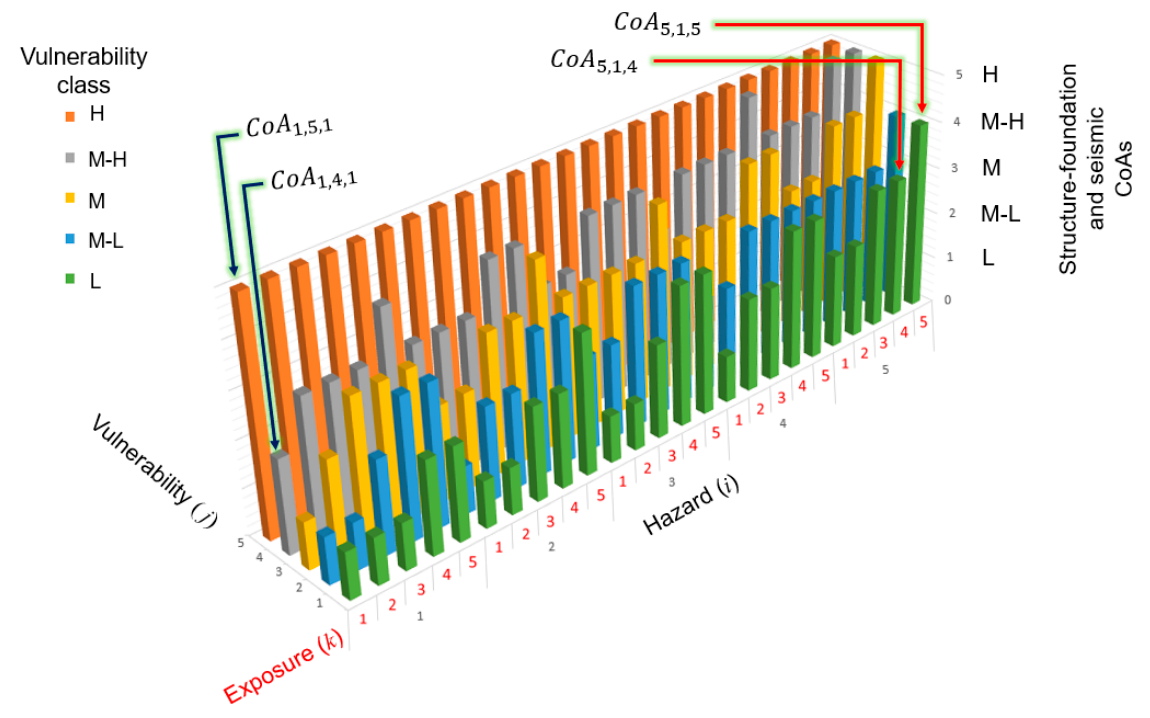
Figure 9. Determination of the structure-foundation and seismic class of attention based on hazard, vulnerability and exposure classes.